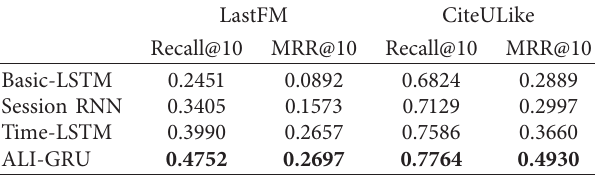
Table 2: Comparison results on LastFM and CiteULike.